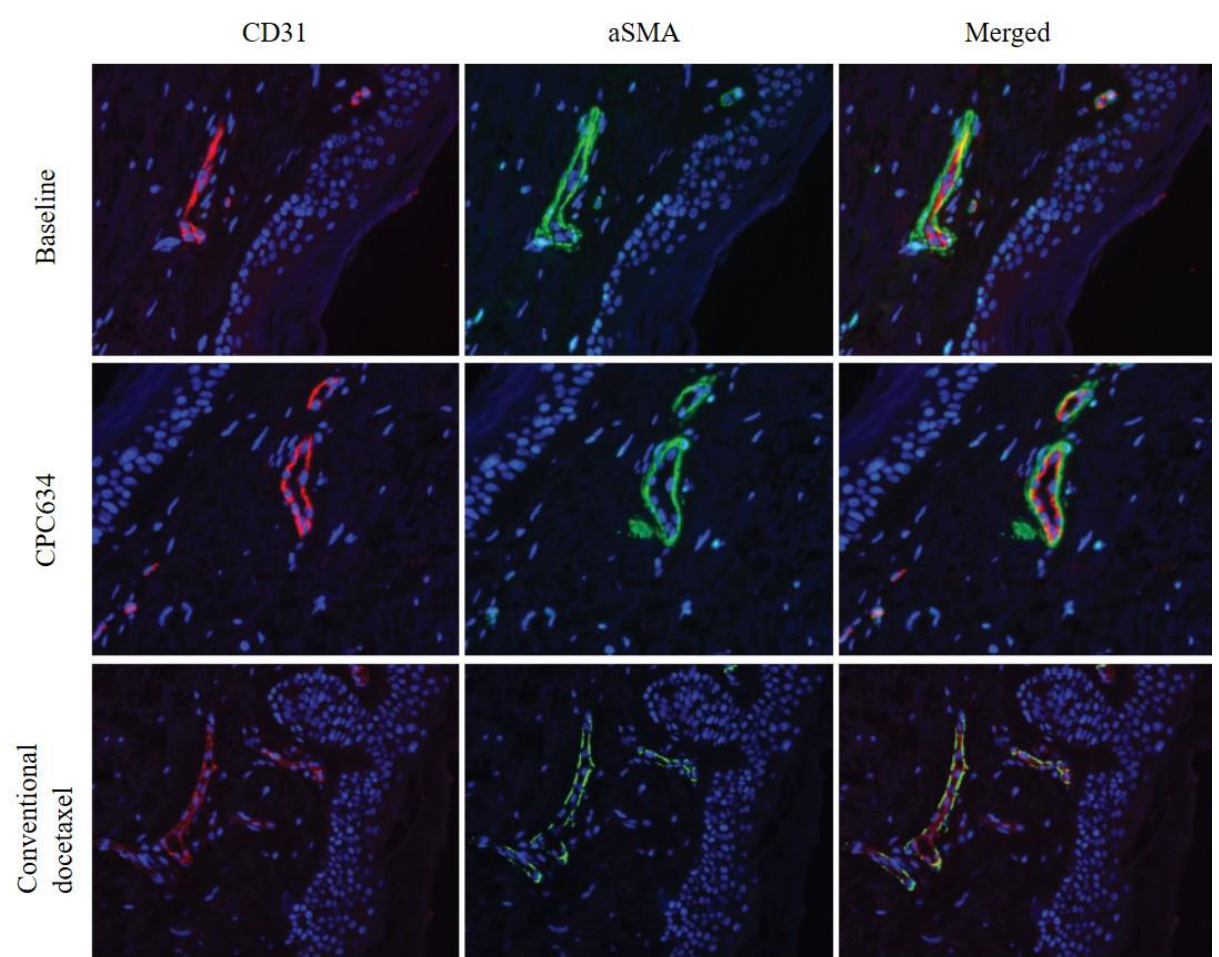
Figure 3. CD31 and aSMA staining of the skin biopsies at baseline, after administration of CPC634 and conventional docet- axel.